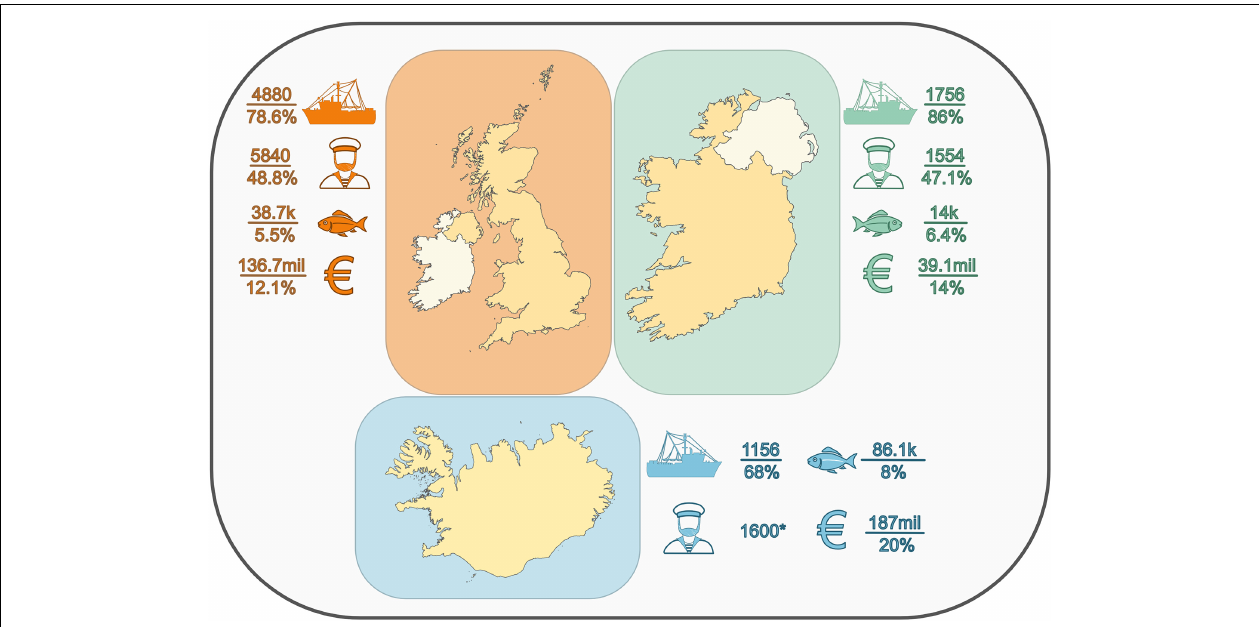
FIGURE 7 | Overview of the SSF parameters presented in the case studies. Number of vessels, number of engaged fishermen, total catch, and total revenue are given (top to bottom, left to right). The upper left section in orange represents the UKs SSF, the upper right section in green represents the Irish SSF, and the bottom section in blue represents the Icelandic SSF. All percentages are the percentage of the national total (unknown is marked with *), all catches are given in t, all revenues in €. All numbers of the UK and Ireland refer to 2018 (STECF, 2020), all numbers for Iceland refer to 2014/15 (Statistics Iceland, 2016; Chambers et al., 2020).